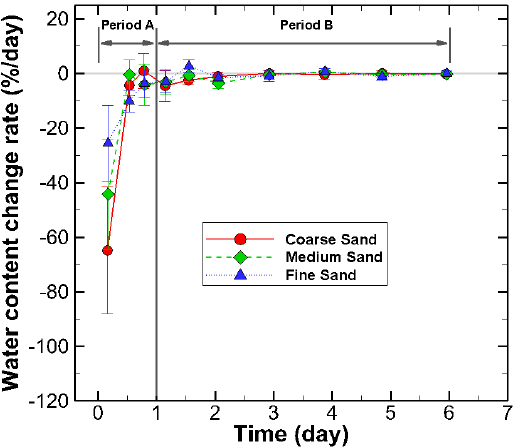
Figure 4. Water content change rates (bars represent the maximum and minimum values).